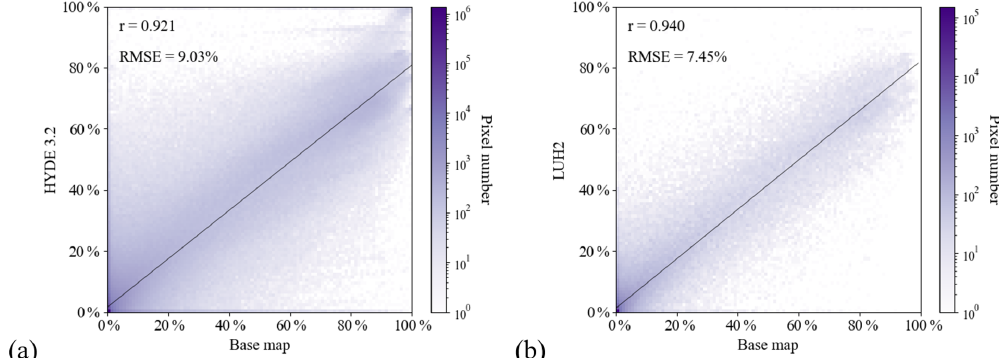
Figure 8. Comparison of cropland proportion in the corresponding pixels between the base map and (a) HYDE 3.2 in 2010CE and (b) LUH2 in 2010CE. Our downscaled maps were aggregated into 10km and 0.25 ◦ resolution for the two comparisons, respectively. The cell value represents the pixel numbers in the corresponding cropland proportion range. The black lines are the linear regression